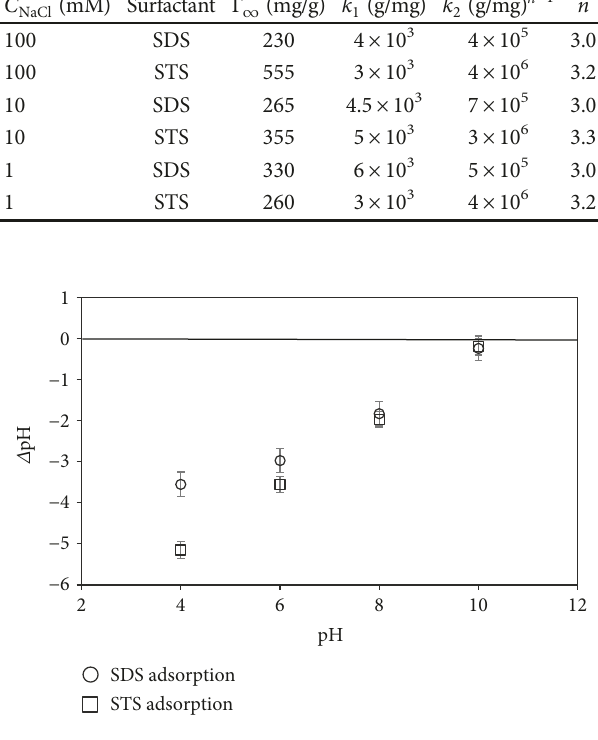
Figure 7: The di ff erences of pH ( Δ pH) after SDS and STS adsorption as a function of initial